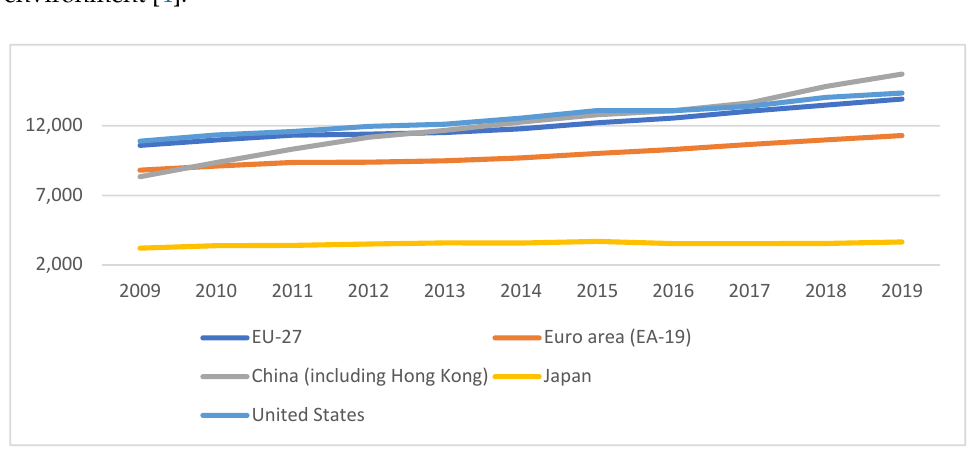
Figure 2. GDP at current market prices [billion PPS], 2009–2019. Source: Eurostat (online data code: prc_ppp_ind).